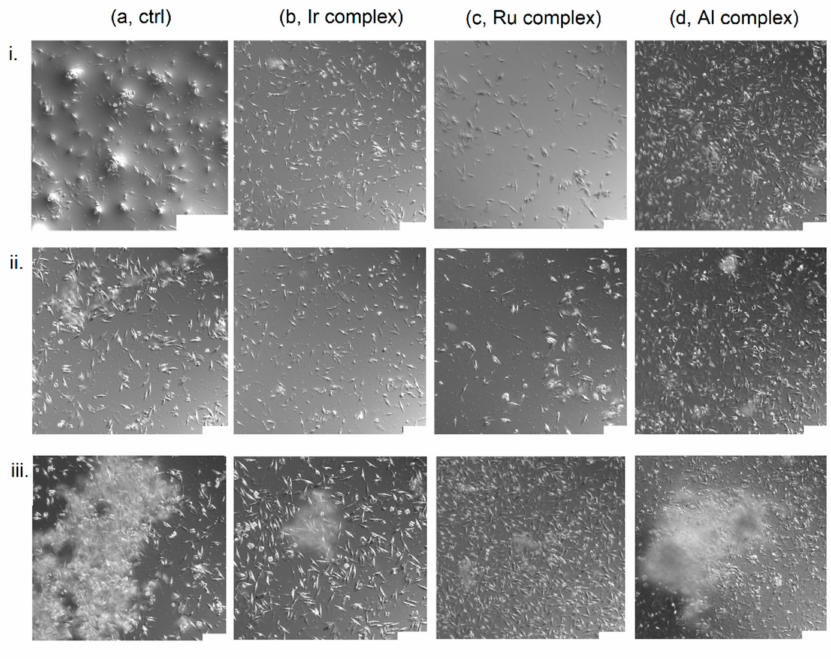
Figure 4. Population study via bright field (DIC mode) microscopy for ( a ) bare, ( b ) Ir-doped, ( c ) Ru-doped, and ( d ) Al-doped cells adhered on conductive indium tin oxide (ITO) substrates at ( i ) 1, ( ii ) 4, and ( iii ) 7 days after immersion of the substrate in cell culture samples. Adhesion was valued after washing and gentle flushing of media over substrates. Scale bars: ( ia ) 100 µ m; ( ib – d ; iia – d ; iiia – d ) 50 µ